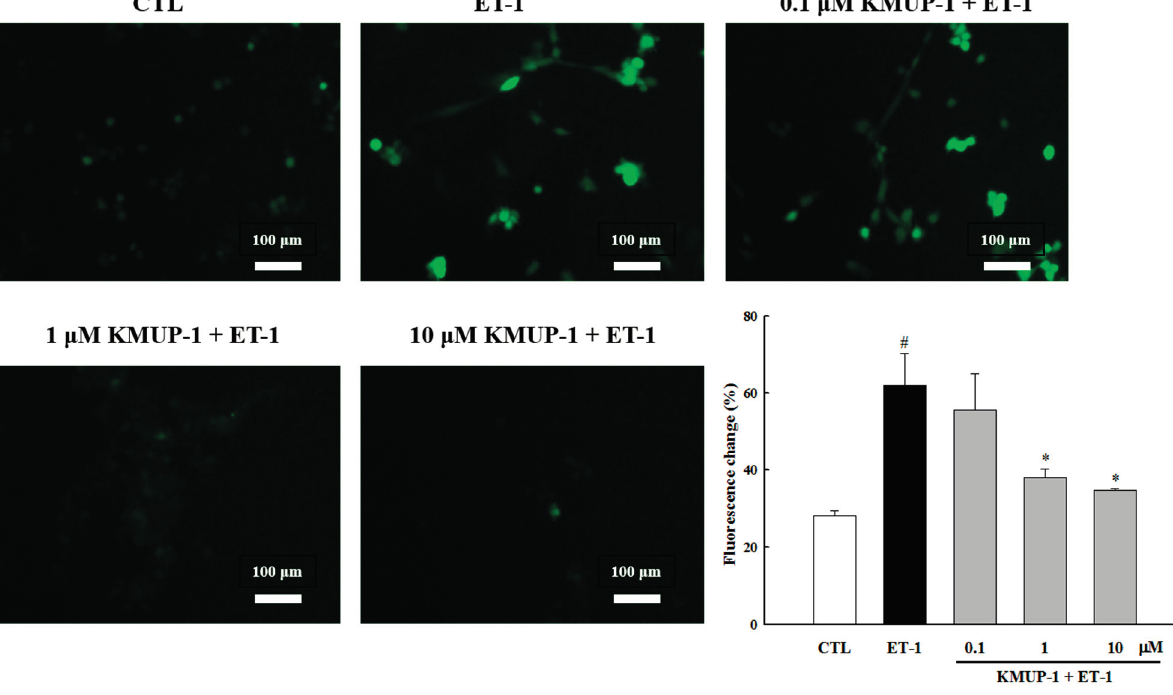
Figure 2. KMUP-1 inhibited ET-1-induced ROS production. Microscopic observation of DCF formation following ROS production (original magnification 200×). H9c2 cells were treated with different doses of KMUP-1 for 1 h, followed by co-treatment with 100 nM ET-1 for 3 h. Each value represents the mean ± SEM of three independent experiments, with triplicate determinations in each experiment. # p < 0.01 compared with control; * p < 0.05 compared with ET-1